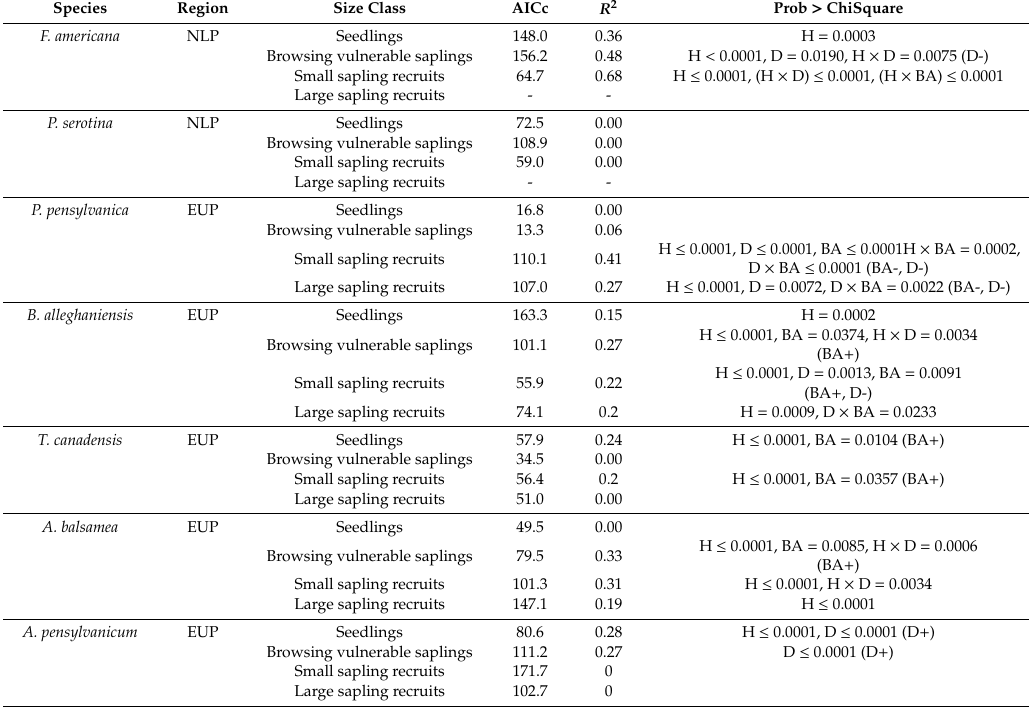
Table A2. Summary of generalized negative binomial models of regeneration strata counts. The elastic net estimation method and AICc validation. Models are for species, regeneration size class, and region combinations for combinations with su ffi cient data for modeling. H = habitat type, D = deer use, BA = current basal area. Models shown are those with best support. H = Habitat Type, D = Deer Use, BA = Basal